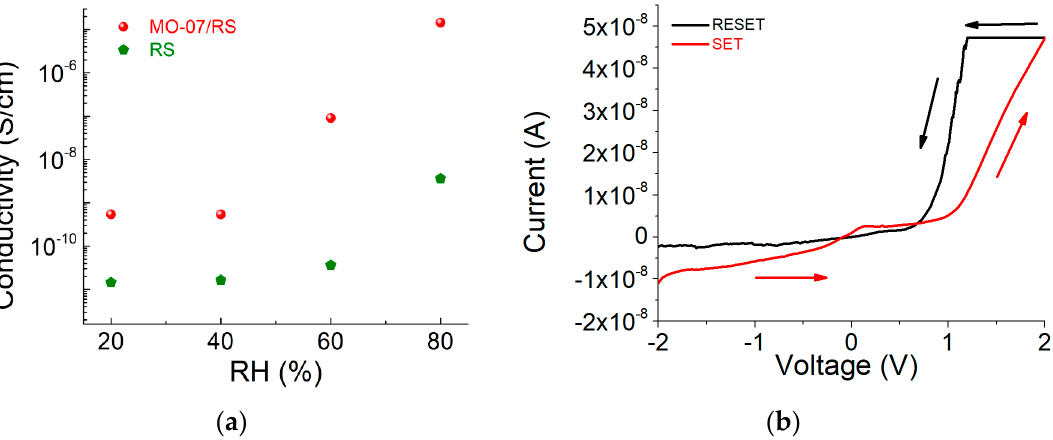
Figure 7. ( a ) Resistivity–humidity curves of RS and MO-07/RS samples. ( b ) I–V characteristic of the MO-07/RS memory device at 80% RH. The voltage sweep direction ( − 2 V → 2 V → 1 V → − 2 V) is indicated with arrows.